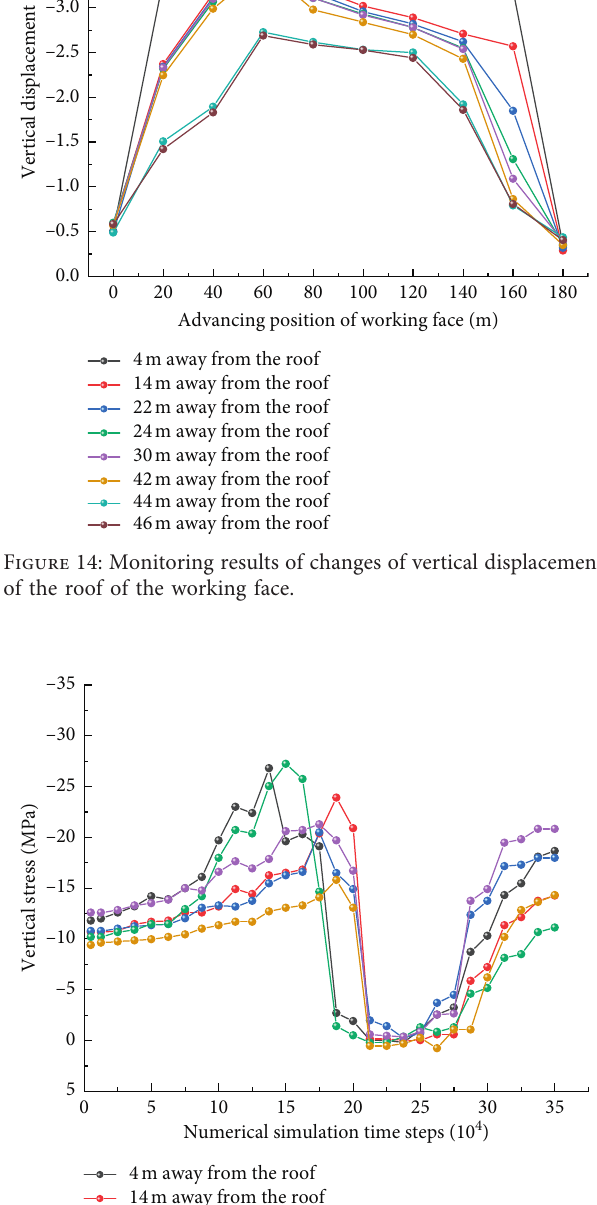
Figure 15: Monitoring results of changes of vertical stress in the roof of the working